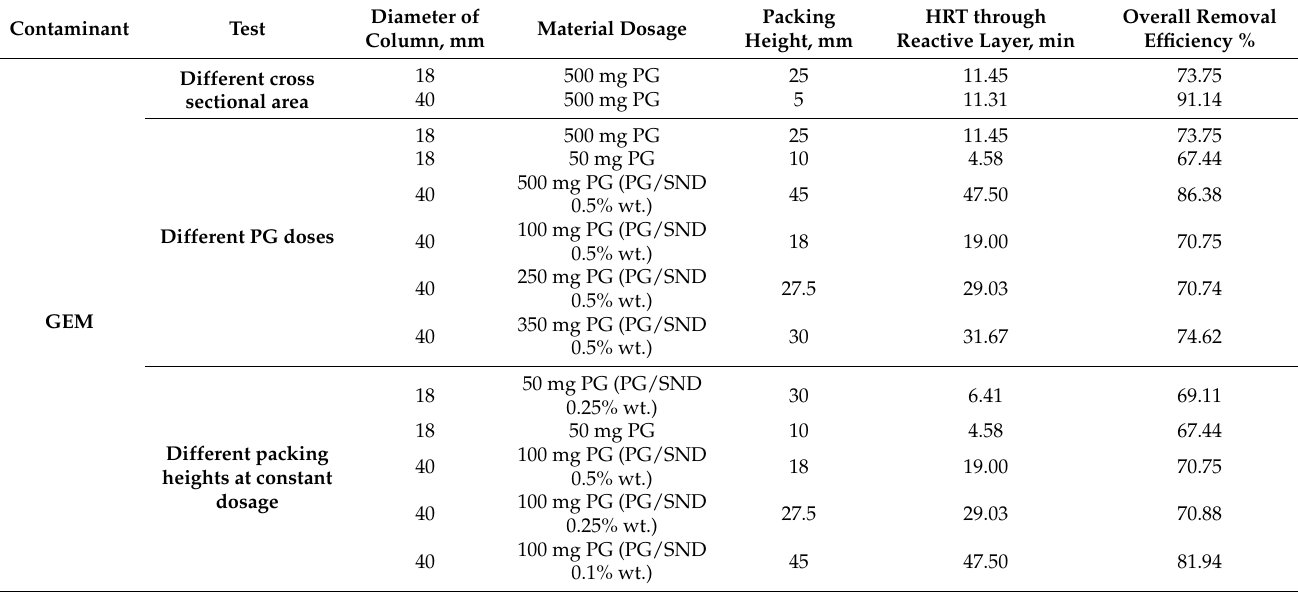
Table 6. Hydraulic retention time and overall removal efficiency of GEM removal by column filters of different cross sectional areas, PG doses, and packing heights at constant dosage. Experimental conditions: ECs-contaminated DW influent adjusted at 10.5 mg/L of EC; room temperature at 22 ± 3 ◦